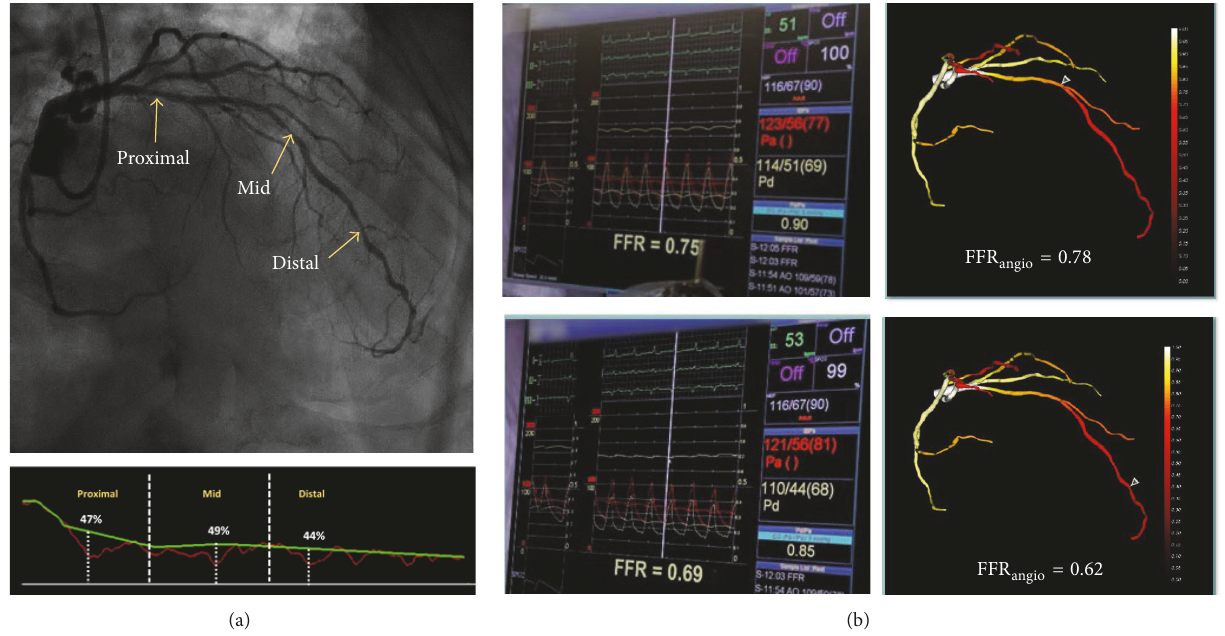
Figure 1: (a) (Top) LAD lesions (arrows indicate the proximal, mid, and distal lesions) and (bottom) corresponding percent diameter stenosis used for diagnostic FFR quantitative coronary angiography (QCA) calculation. (b) Invasive fractional flow reserve (FFR) measurements angio (left) of the middle (top) and distal (bottom) lesions and the corresponding values calculated by the FFR